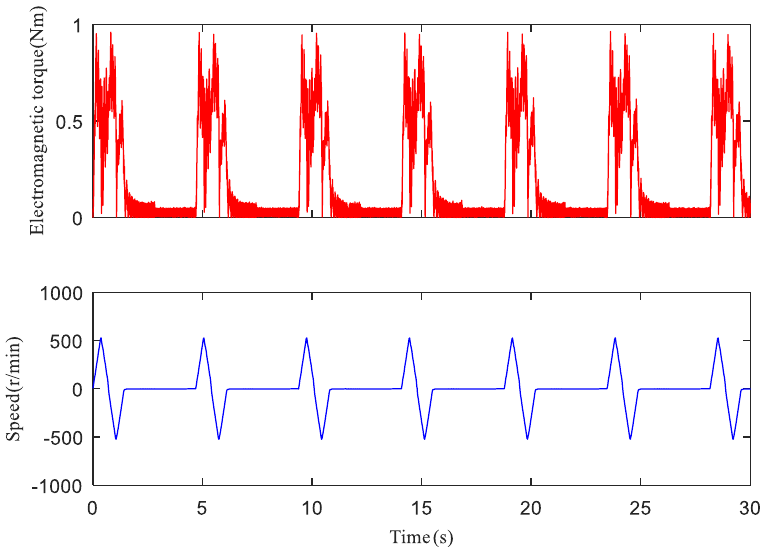
Figure 7. Input and output signal of the test bench when the acceleration time was 0.5 s.